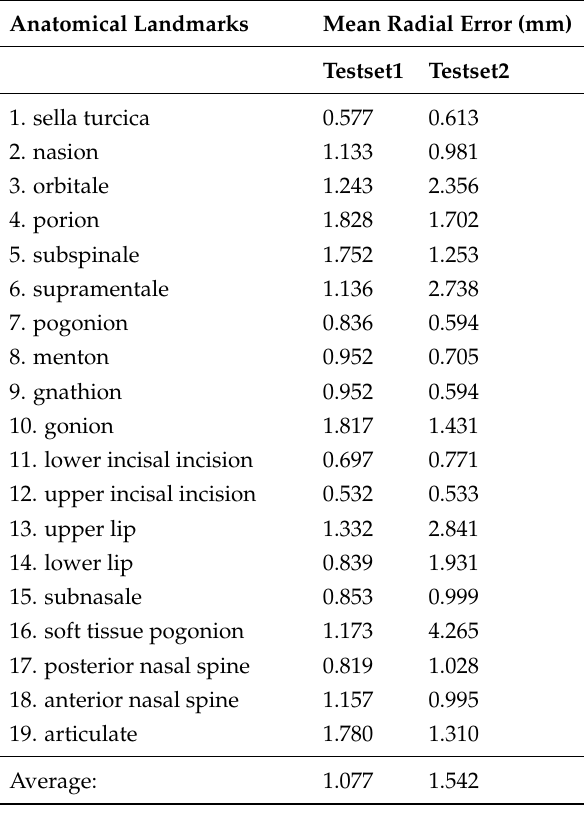
Table 2. Results on Testset1 and Testset2 of mean radial error.